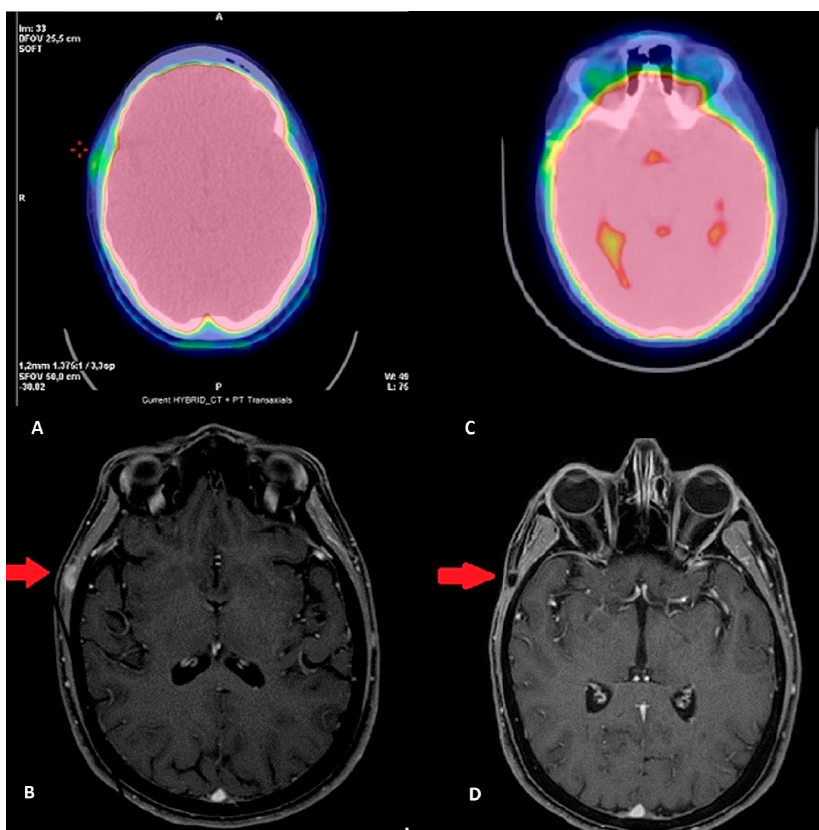
Figure 3. ( A , B ) Pre-operative imaging: ( A ) FDG PET/CT: shows the uptake of the lesion (green area in the upper-left part of the panel); ( B ) MRI: the red arrow indicates the lesion. ( C , D ) Twelve months after surgery: ( C ) FDG PET/CT shows no uptake; ( D ) MRI shows the surgical alteration of the temporal muscle without contrast-enhancement, and the red-arrow indicates the area.